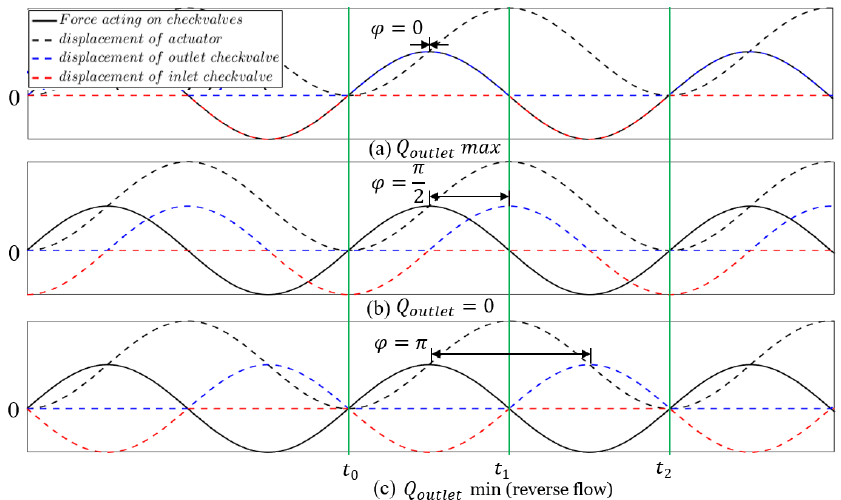
Figure 3. The assumed relationship between the displacement of the PZT actuator and the check valves (scaled). ( a ) phase shift 𝜑 = 0 , ( b ) phase shift 𝜑 = 𝜋/2 , ( c ) phase shift 𝜑 = 𝜋 .